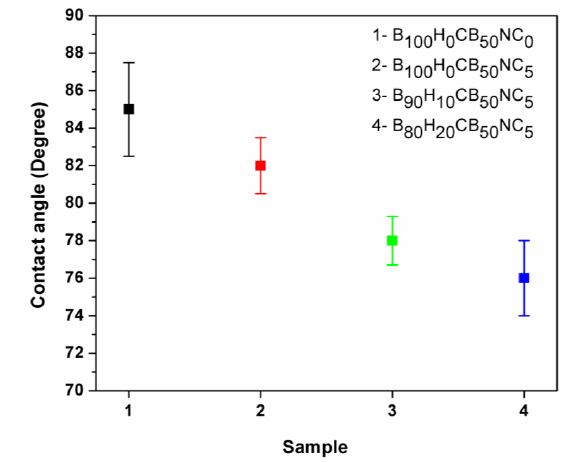
Figure 6: Surface hydrophilicity of the samples using contact angle measurement.